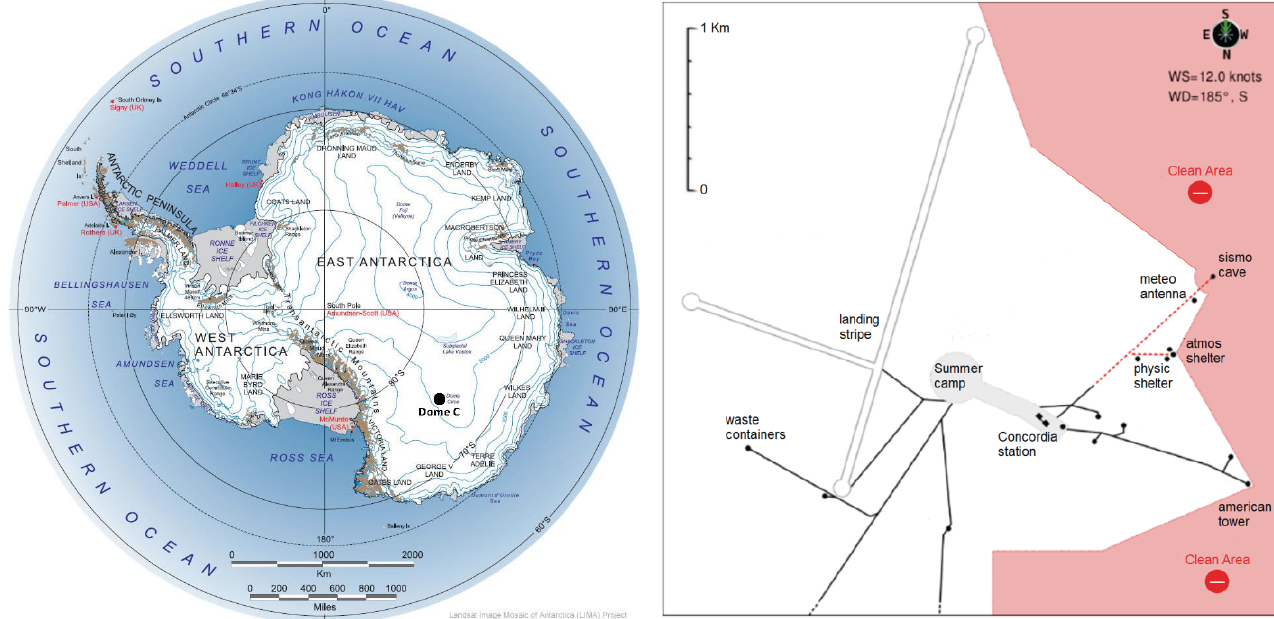
Figure 2. Map of Antarctica ( left ). The ATMOS shelter is located 700 km far from Concordia Station ( right